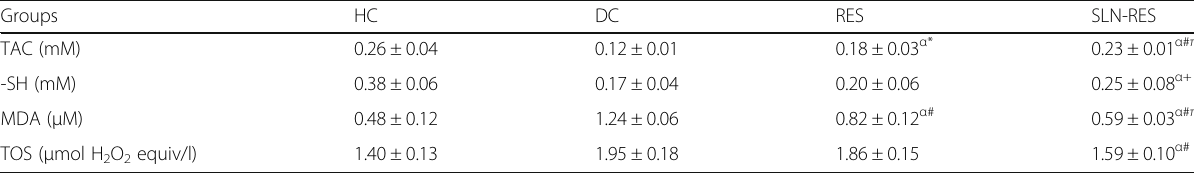
HC healthy control, DC diabetic control, RES resveratrol treatment 10mg/kg, SLN-RES resveratrol-loaded solid lipid nanoparticles containing 10mg/kg of resveratrol, TAC total antioxidant capacity, -SH total thiol group, MDA malondialdehyde, TOS total oxidant status. Data were expressed as mean±SD α Compared to the DC group δ There was a significant difference between RES and SLN-RES group ( p <0.05) π Restored to the HC group (there was no significant difference compared to the HC group ( p >0.05)). * p <0.05